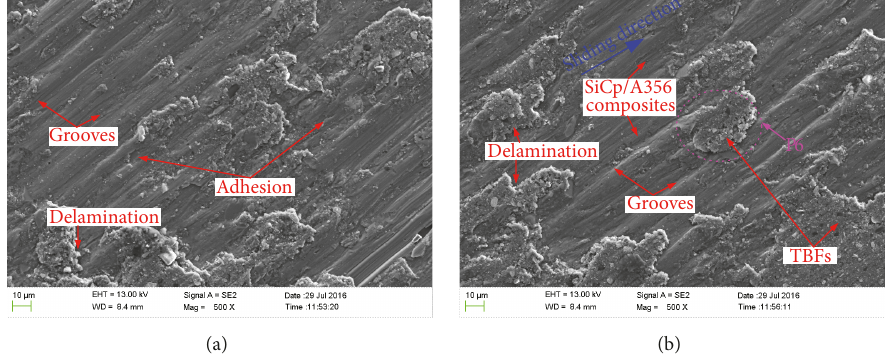
Figure 12: The surface topography of composites specimen for the test of 100 ∘ C ∼ 200 ∘ C: (a) 500x and (b) 500x.